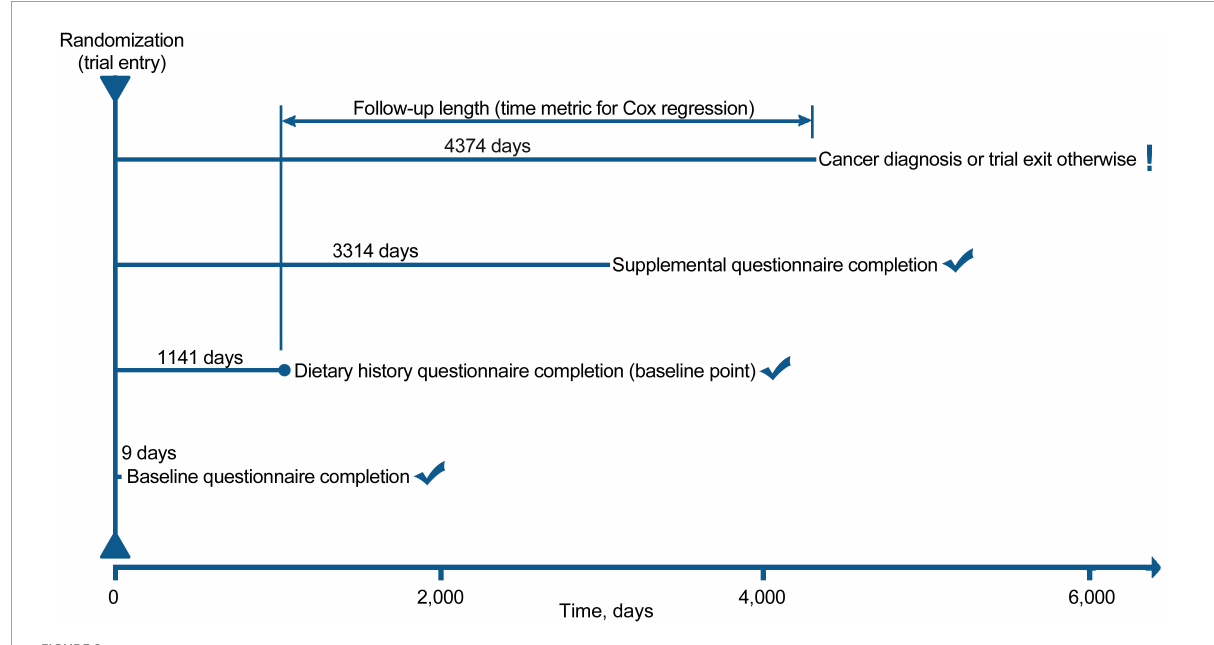
FIGURE2 The timeline and follow-up scheme of our study.